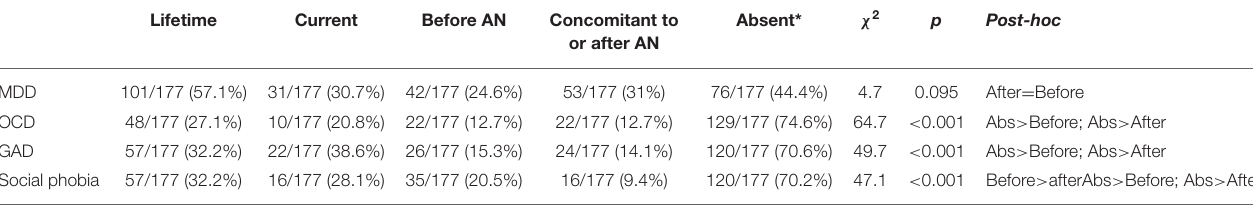
TABLE 2 | Psychiatric disorder comorbidities over a lifetime: prevalence and chronology of onset ( n = 177). Lifetime Current Before